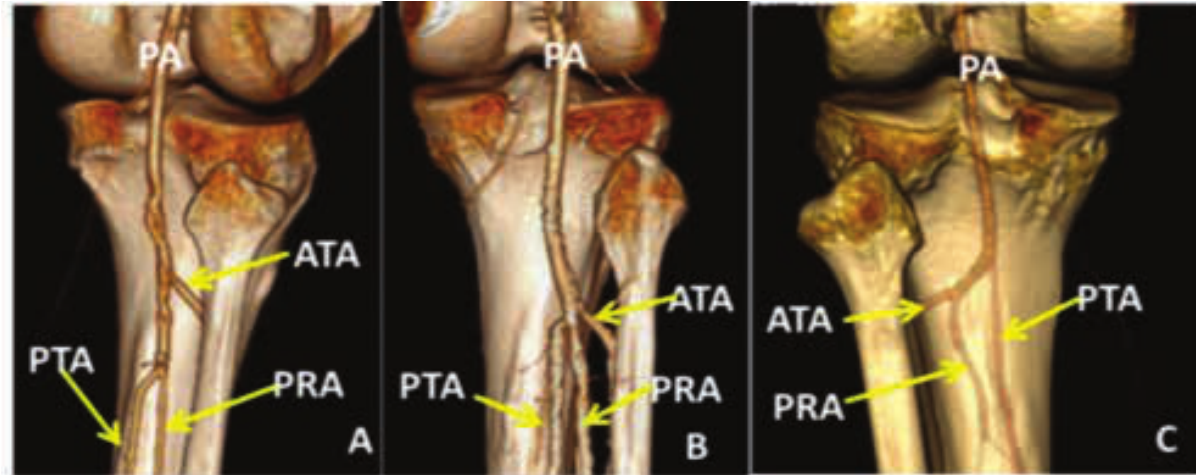
Figure 2.A-C: The volume-rendered (VR) MDCT images show the Type I branching pattern of the popliteal artery (PA). Type IA pattern (A) in the right lower extremity; the first branch of the PA is the anterior tibial artery (ATA), peroneal (PRA), and posterior tibial arteries (PTA) arise from tibioperoneal trunk. Type IB pattern (B) in the right lower extremity; branching of ATA, PTA, and PRA within a distance of 0.5 cm without formation of a true tibioperoneal trunk. Type 1C pattern (C) in the left lower extremity; PTA is the first branch, and ATA, and PRA arise from the tibioperoneal trunk.